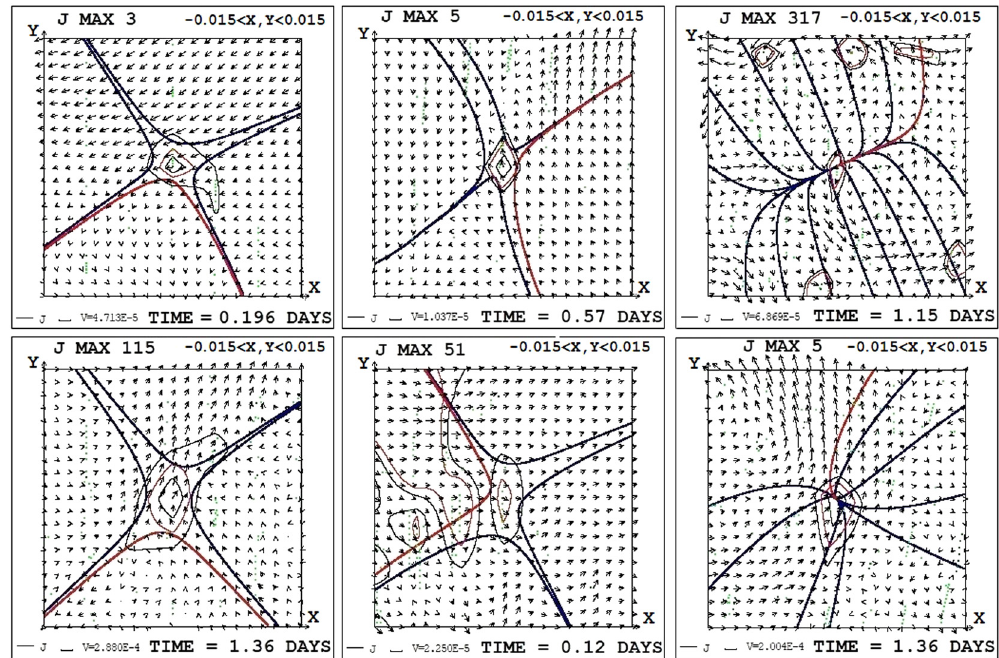
Figure 4: Examples of superposition of X - type and diverging magnetic fi eld near current density maxima situated on singular lines obtained from MHD simulation. Magnetic fi eld con fi gurations and plasma fl ow in the plane of con fi guration which is perpendicular to the vector of magnetic fi eld in the point of current density maximum. Plane magnetic fi eld con fi guration is represented by lines tangent to the projections of the magnetic fi eld vectors on the plane of con fi guration. The scale of the velocity vector is shown in dimensionless units ( the unit is typical Alfven velocity equal to V 0.65 10 cm s A 10 = × / ) . Constant current density lines are presented as thin lines. The linear size of region is 0.03 ( 12 mM )